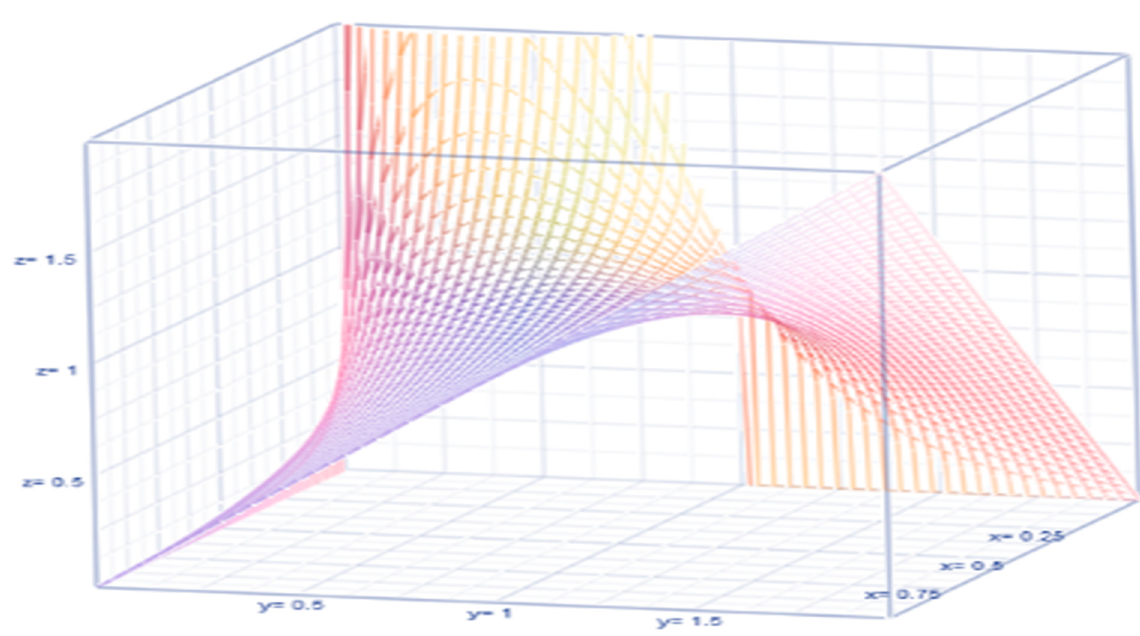
1/ γ (cid:82) ( φ )( γθ ) φ d θ = 1. For example, θ